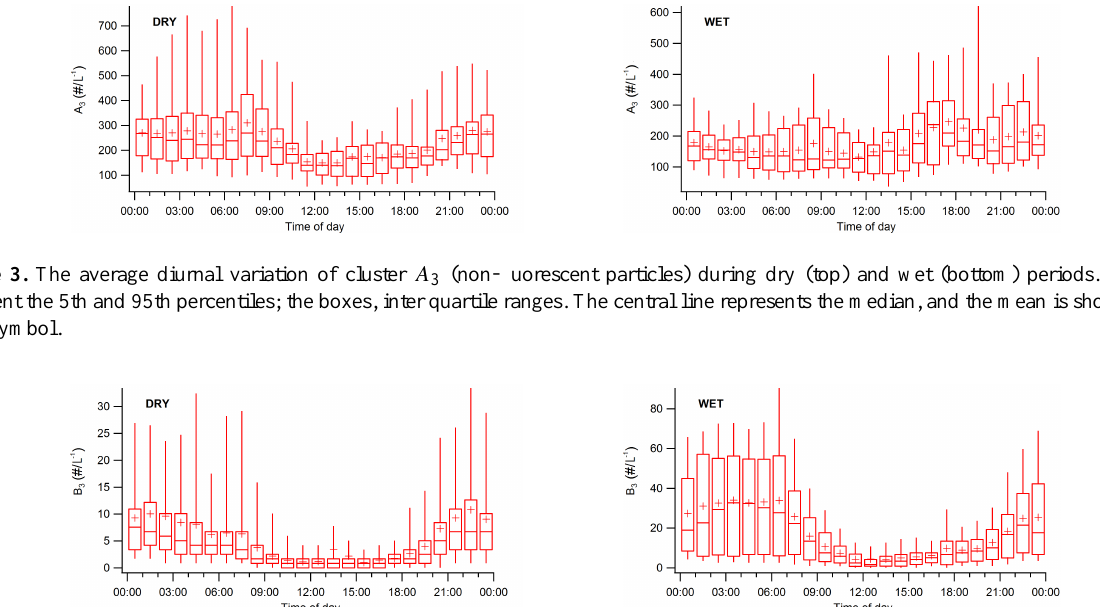
concentration of particles in D 3 were higher during wet peri-